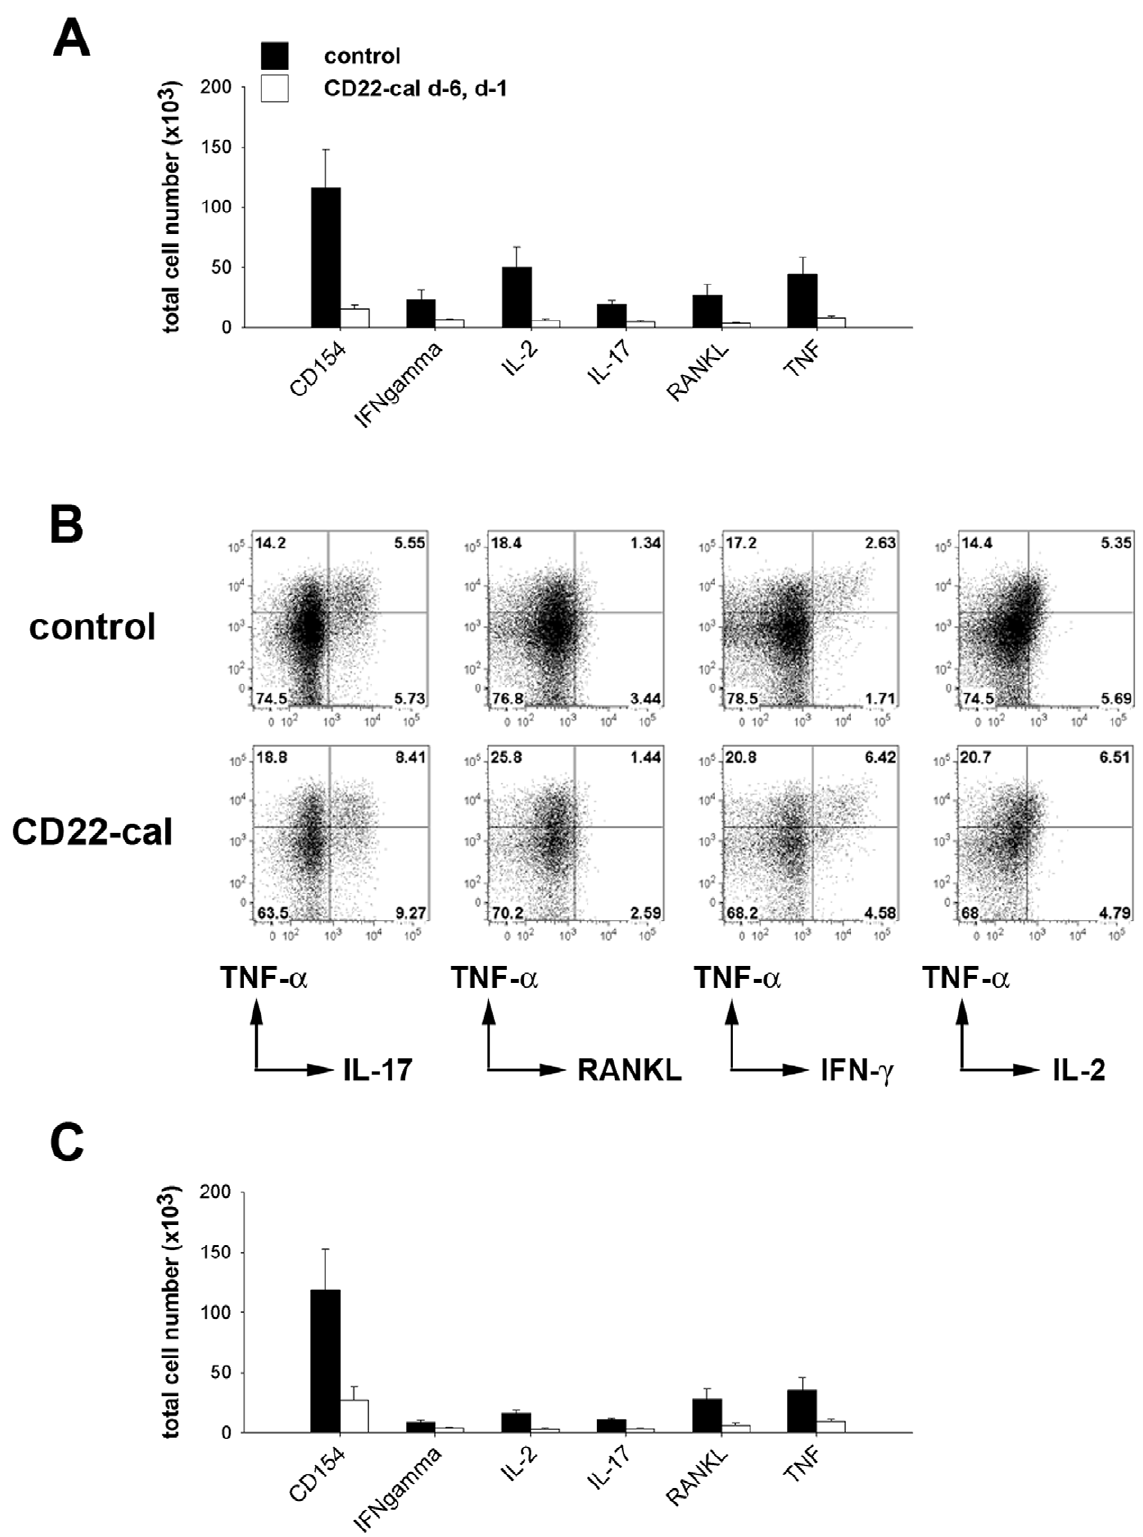
Figure 6. G6PI-specificTh cell response in CD22-cal treated mice. Mice were treated with CD22-cal at days 2 6 and 2 1 and were immunized with 400 m g G6PI in complete Freund’s adjuvant. Control were immunized but otherwise left untreated. At day 9 after immunization, cells from the draining lymph nodes (inguinal, axillary, paraaortic) were restimulated with G6PI, fixed and stained for flow cytometry. A) Absolute number of G6PI- specific (CD154 + ) and G6PI-specific Th cells, expressing the indicated cytokine recovered from the draining lymph nodes of control or CD22-cal treated animals ( n =4 per group). B) Representative flow cytometry data from control (upper row) and CD22-cal treated (lower row) mice. Dot plots